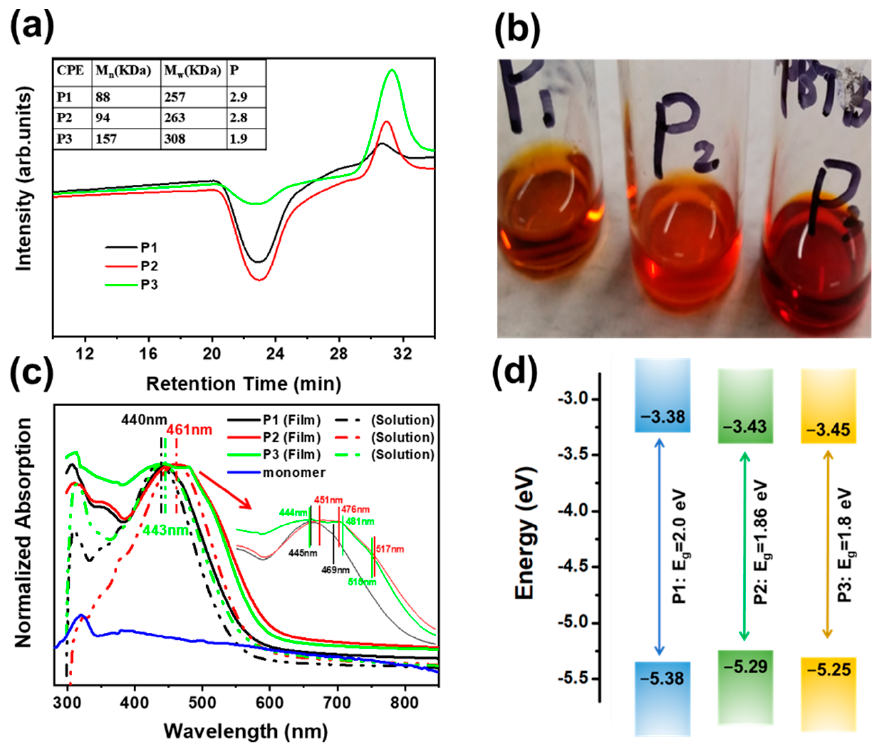
Figure 2. ( a ) The GPC of P1, P2 and P3. ( b ) The photograph of P1, P2 and P3 (5 mg/mL) solutions. ( c ) The normalized absorptions of P1, P2 and P3 in solution and thin film. The inset illustration shows the enlarged absorptions of P1, P2 and P3 films. ( d ) Energy level diagram of P1, P2 and P3. Table 1. The absorption peaks of P1, P2 and P3 solutions and thin films. The λ EX is the abbreviation of corresponding absorption peak.